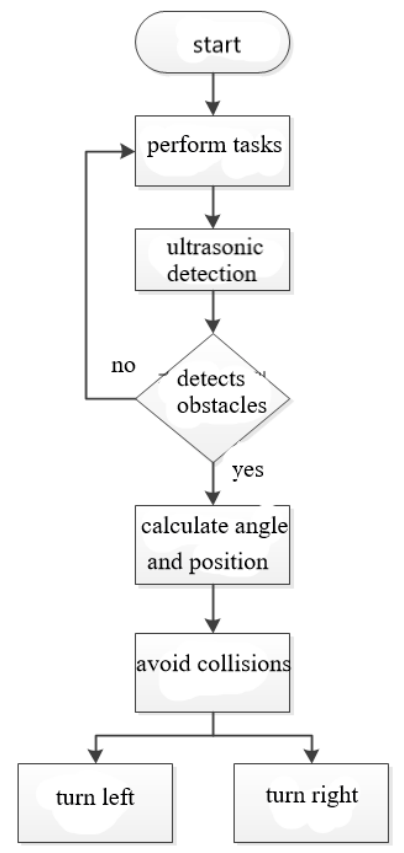
Figure 18. Operation flowchart of ultrasonic sensors.